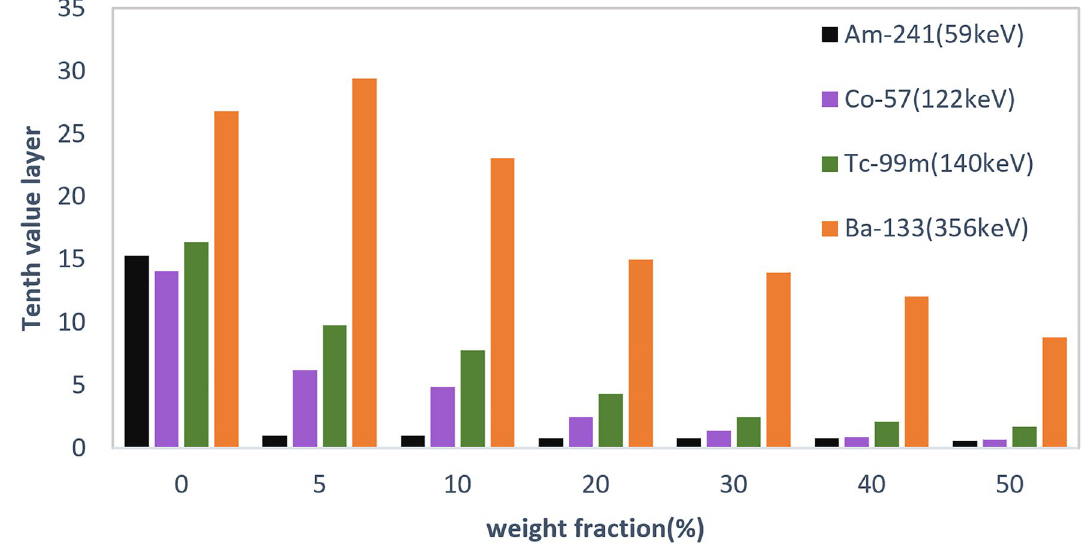
Figure 10. Tenth value layer results for different filler levels of PC/Bi 2 O 3